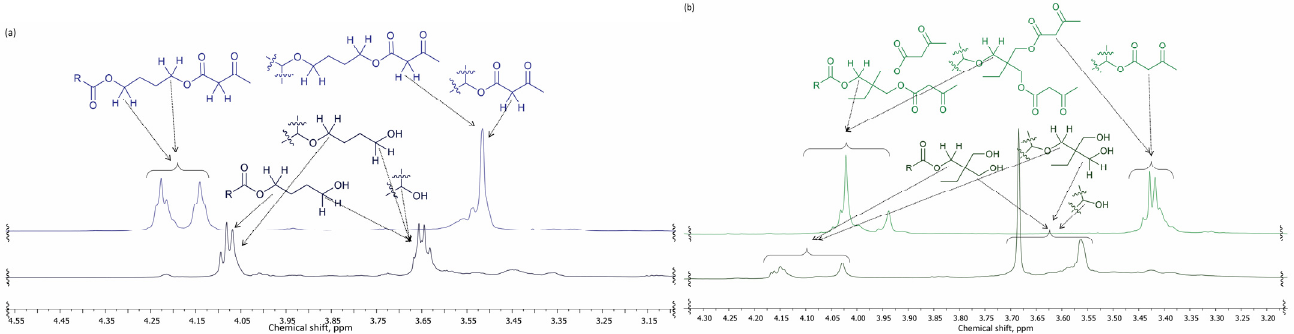
Figure 7. 1 H-NMR spectra of: ( a ) E IR TOFA_BD and E IR TOFA_BD_AA (500 MHz, CDCl 3 ); ( b ) E IR TOFA_TMP and E IR TOFA_TMP_AA (500 MHz, CDCl 3 ).